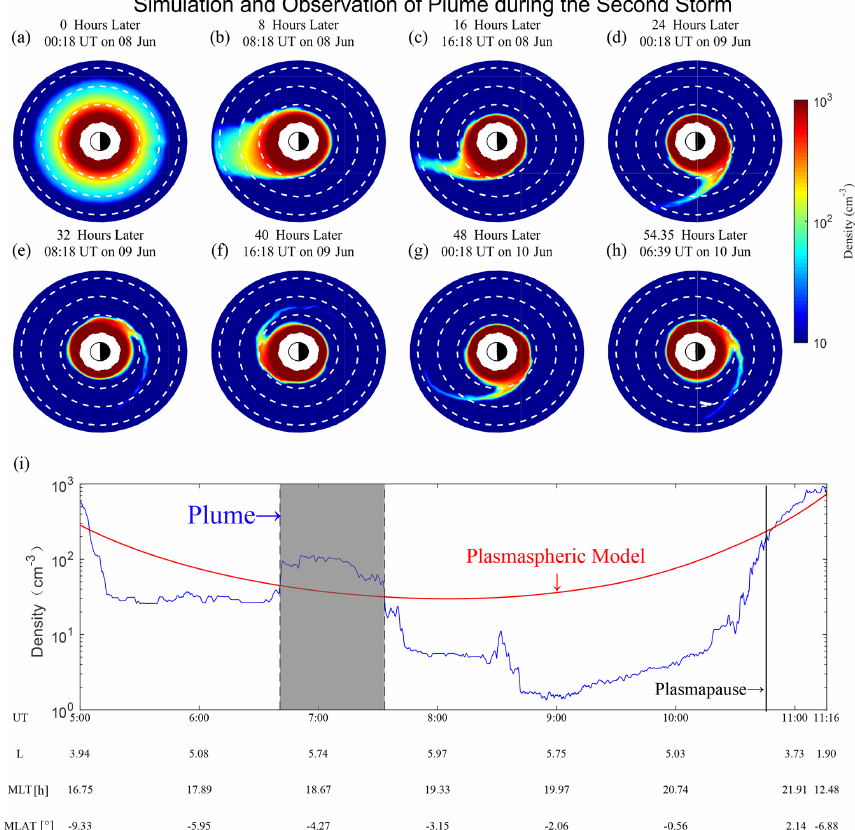
Figure 10. (a–h) Equatorial plots of the plasmasphere and plume obtained by simulation in the time interval of 8–10 June 2015. The dotted white circles, from inside out, indicate L shell values of 4, 6, and 8. The simulation duration and the corresponding actual duration are represented in the title. The solid white line in (h) represents the orbit arc in which the VAP-A observed the plasmaspheric plume from 06:39 to 07:31UT on 10 June. (i) The plasma density detected by the VAP-A from 05:00 to 11:16UT on 10 June 2015. The gray shadow indicates the plasmaspheric plume detected by the